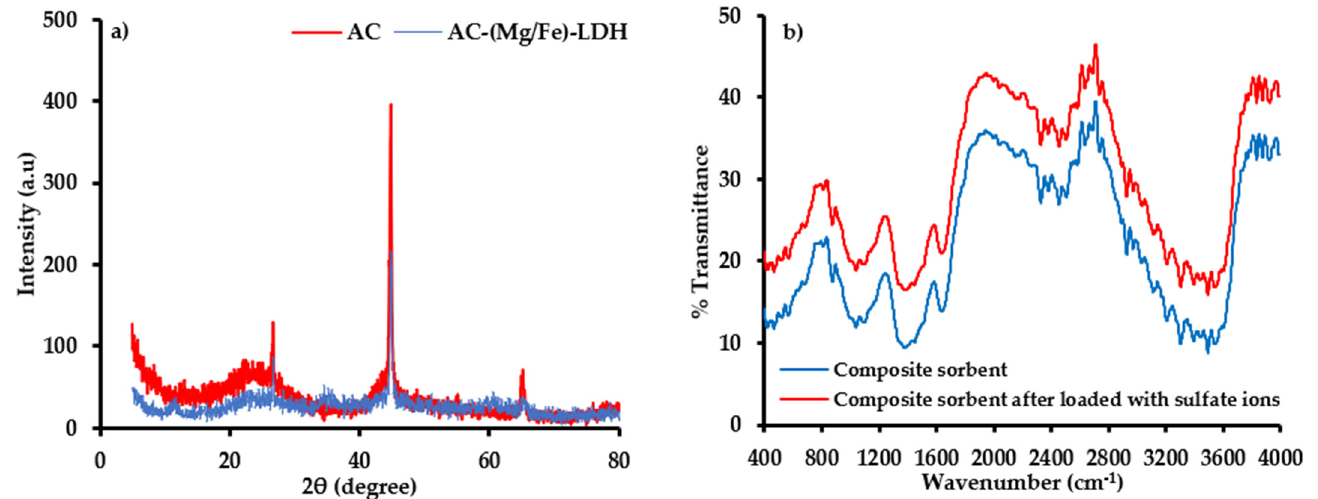
Figure 4. ( a ) Pattern of XRD for structure of AC and AC-(Mg/Fe)-LDH and ( b ) FT-IR test for (scrap iron +AC-(Mg/Fe)-LDH) sorbent before and after interaction with SO 42 − ions.